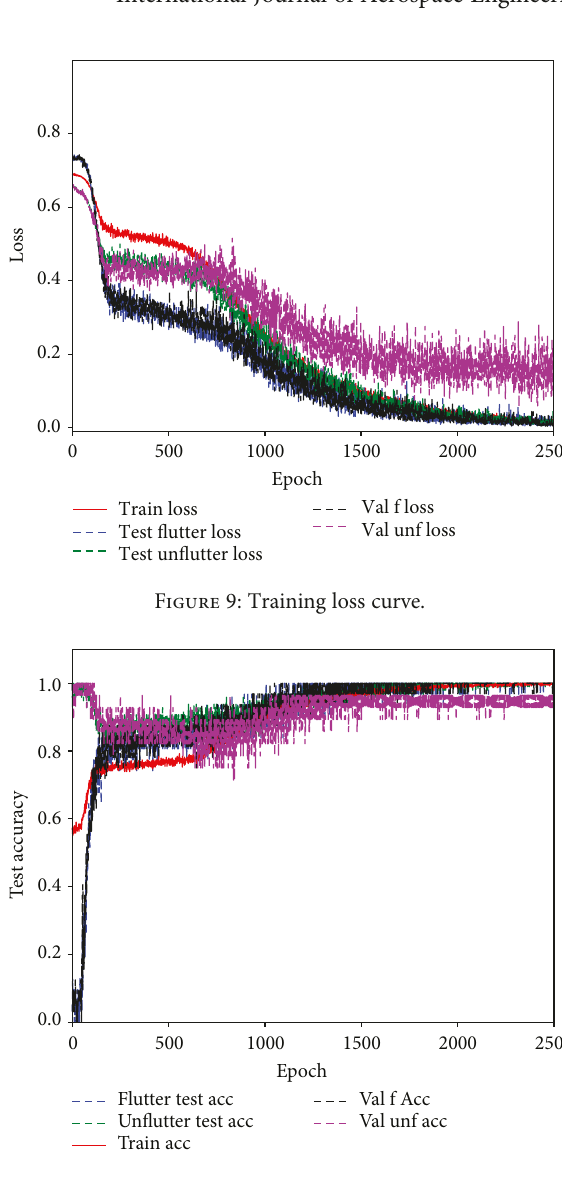
Figure 10: Accuracy rate